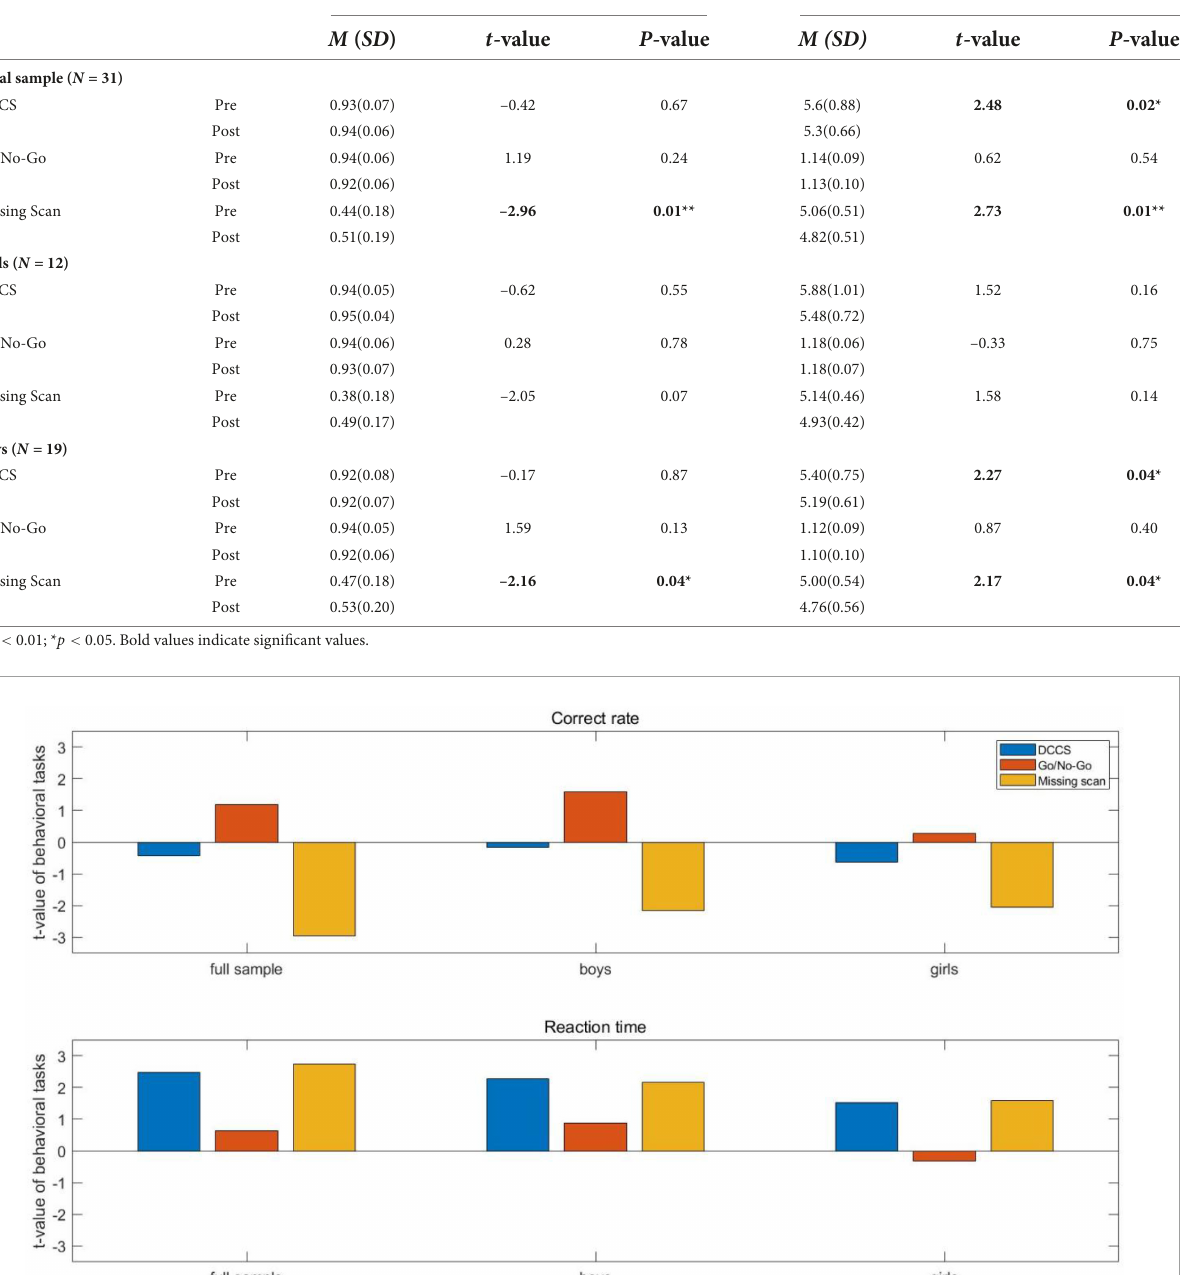
used as test stimuli. Examples of animals in the test set include monkey, pig, butterfly, and duck. Children were instructed to name pictures of each animal before carrying out the test to prevent the need to learn new vocabulary. The child used this label consistently and did not refer to another animal in the same